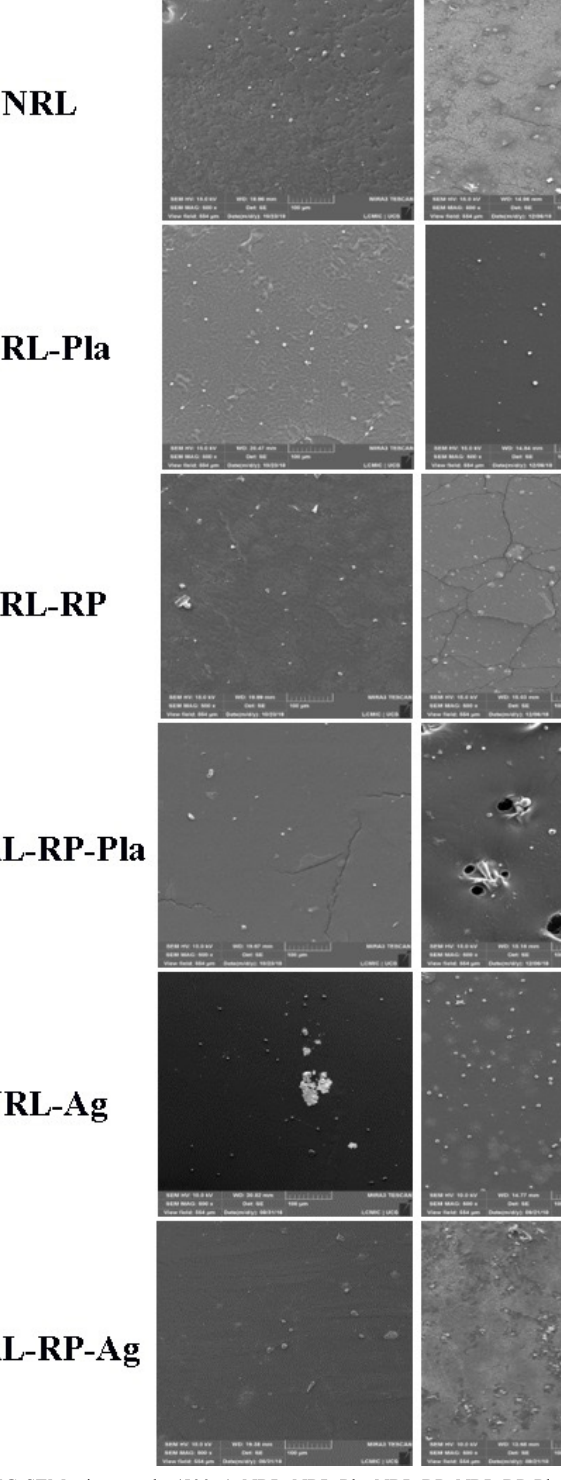
Figure 8. FEG-SEM micrographs (500 ×). NRL; NRL-Pla; NRL-RP; NRL-RP-Pla; NRL-Ag; NRL-RP-Ag after 1, 2 and 7 days of L929 cellular